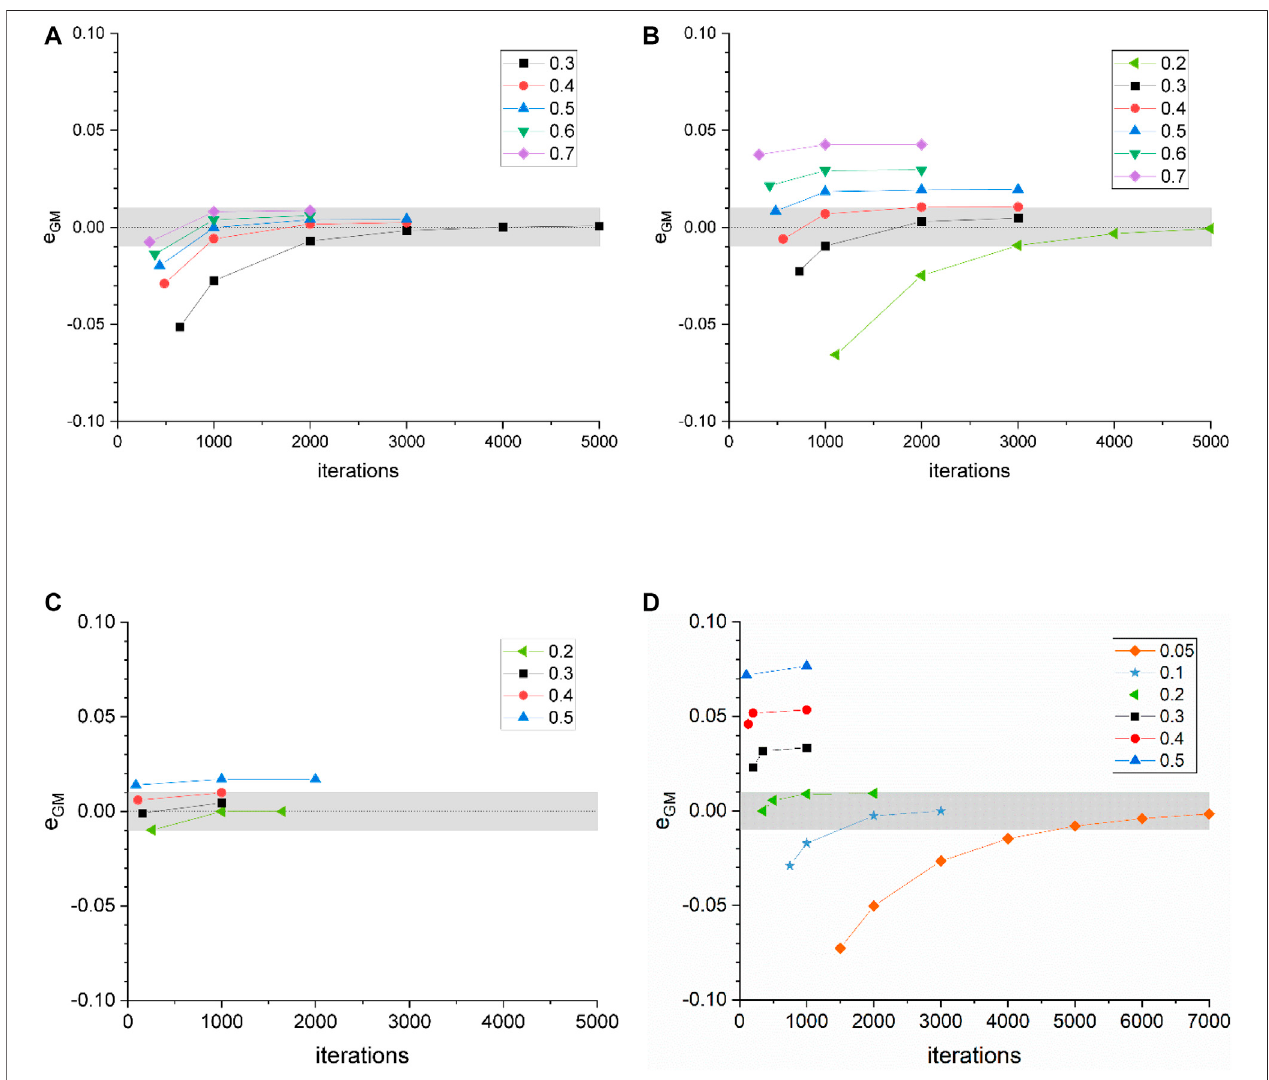
FIGURE 12 | Geometric mean permeability error depending on mesh cell size and SIMPLE iterations; (A) axial case with 20% fi ber volume fraction; (B) transverse case with 20% fi ber volume fraction; (C) axial case with 45% fi ber volume fraction; (D) transverse case with 45% fi ber volume fraction.